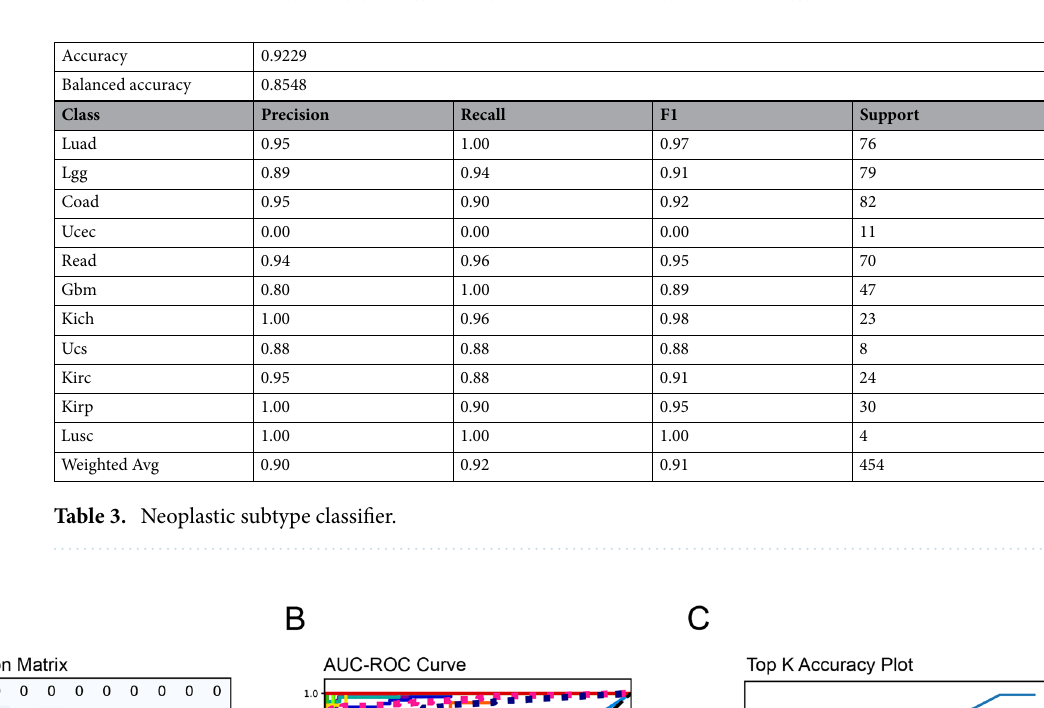
Figure 3. Performance of tissue origin classifier. ( A ) Confusion matrix of tissue origin classifier; ( B ) Receiver operating characteristic curve (ROC) with area under the curve (AUC); ( C ) top K accuracy plot.